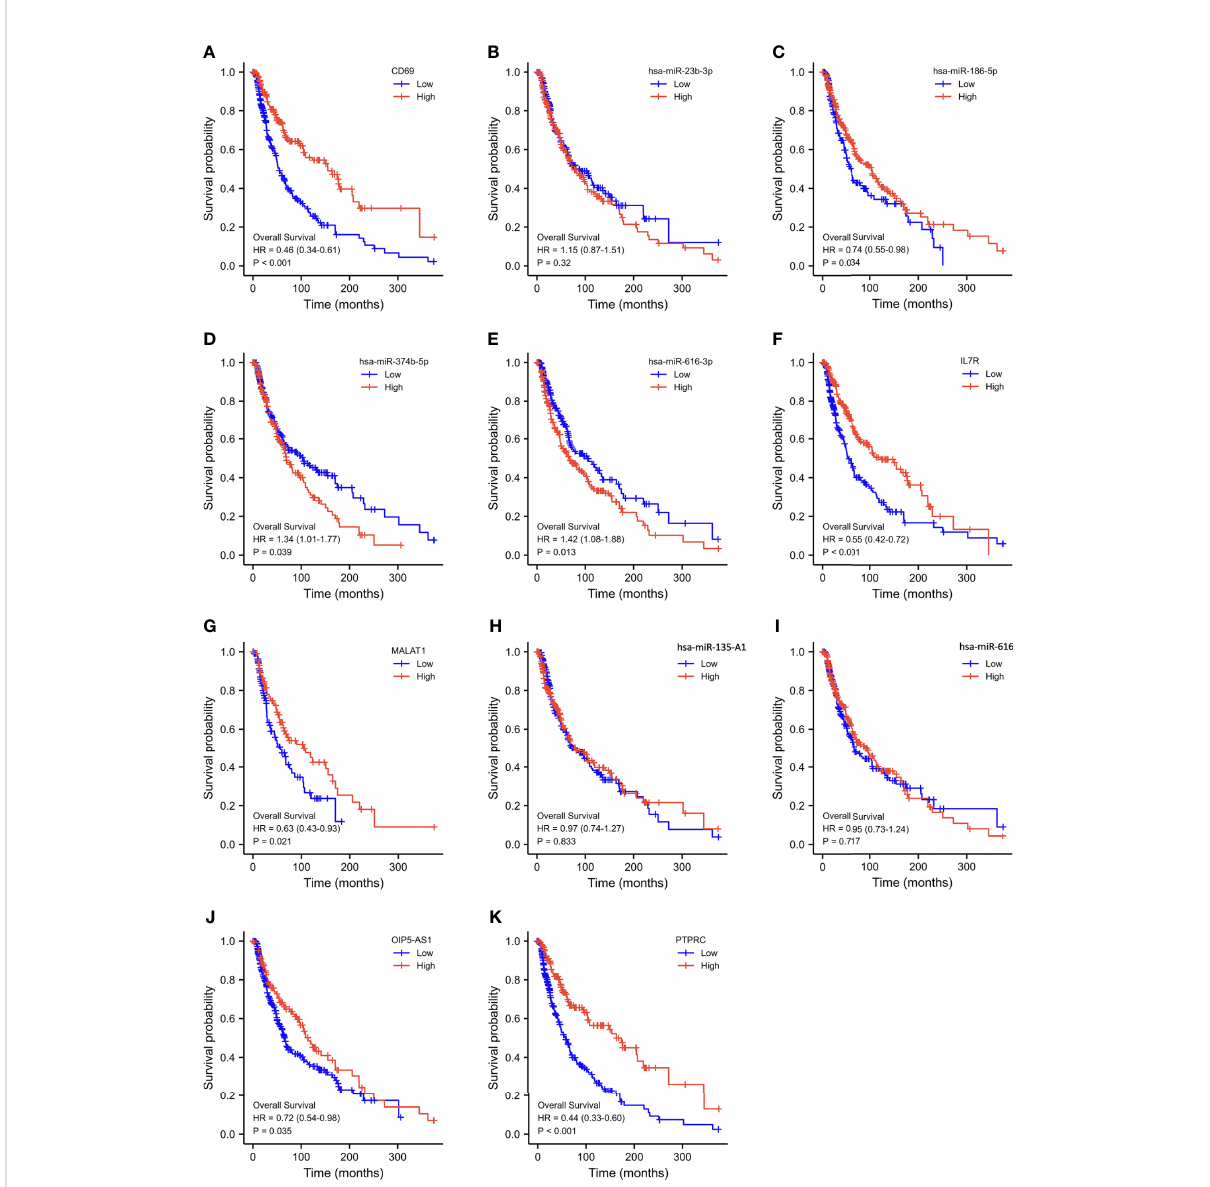
FIGURE 6 Overall survival analysis based on the expression levels of RNAs in the triple regulatory network. (A – K) Expression of ten hub-genes in the SKCM dataset with CD69 high and CD69 low , hsa-miR-23b-3p high and hsa-miR-23b-3p low , hsa-miR-186-5p high and hsa-miR-186-5p low , hsa-miR-374b- 5p high and hsa-miR-374b-5p low , hsa-miR-616-3p high and hsa-miR-616-3p low , IL7R high and IL7R low , MALAT1 high and MALAT1 low , hsa-miR- 135A1 high and hsa-miR- 135A1 low , hsa-miR- 616 high and hsa-miR- 616 low , OIP5-AS1 high and OIP5-AS1 low , and PTPRC high and PTPRC low expression groups, which were compared using a Kaplan – Meier survival curve for TCGA SKCM patient cohort. The horizontal axis indicates the overall survival time in months and the vertical axis represents the survival